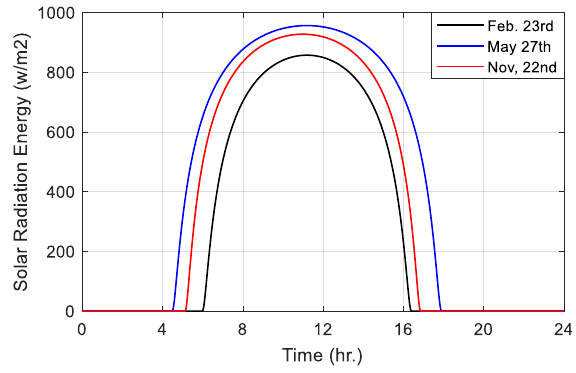
Figure 14. Estimated sun energy on a flat surface.